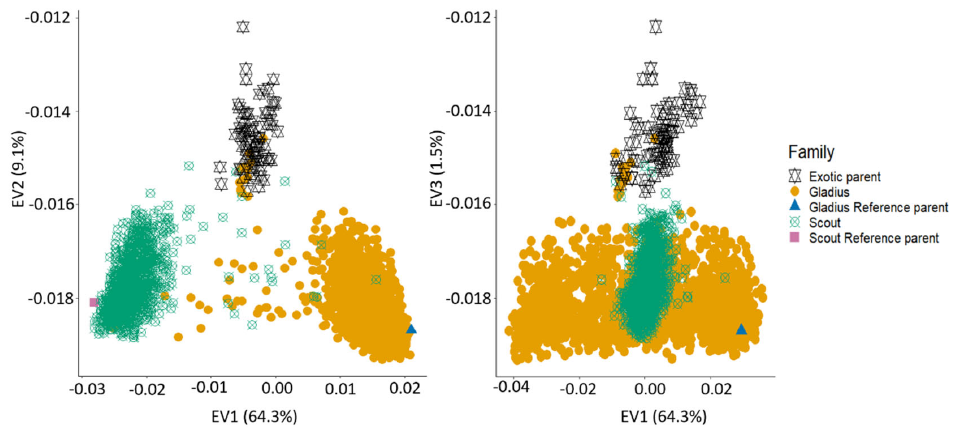
Figure 4. Population structure of the OzNAM population and their parents. Percentages on each axis refer to the proportion of variation explained by each